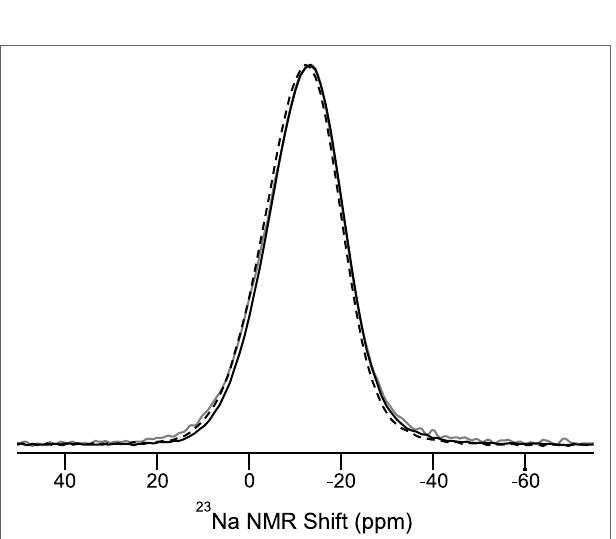
FigUre 12 | 23 na Mas nMr spectra of three different aluminosilicate glasses ion exchanged at 410°c: as-prepared (gray line), compressed at 1 gPa and 650°c (dashed black line), and annealed for 168 h at 0.92 T g (solid black line) .